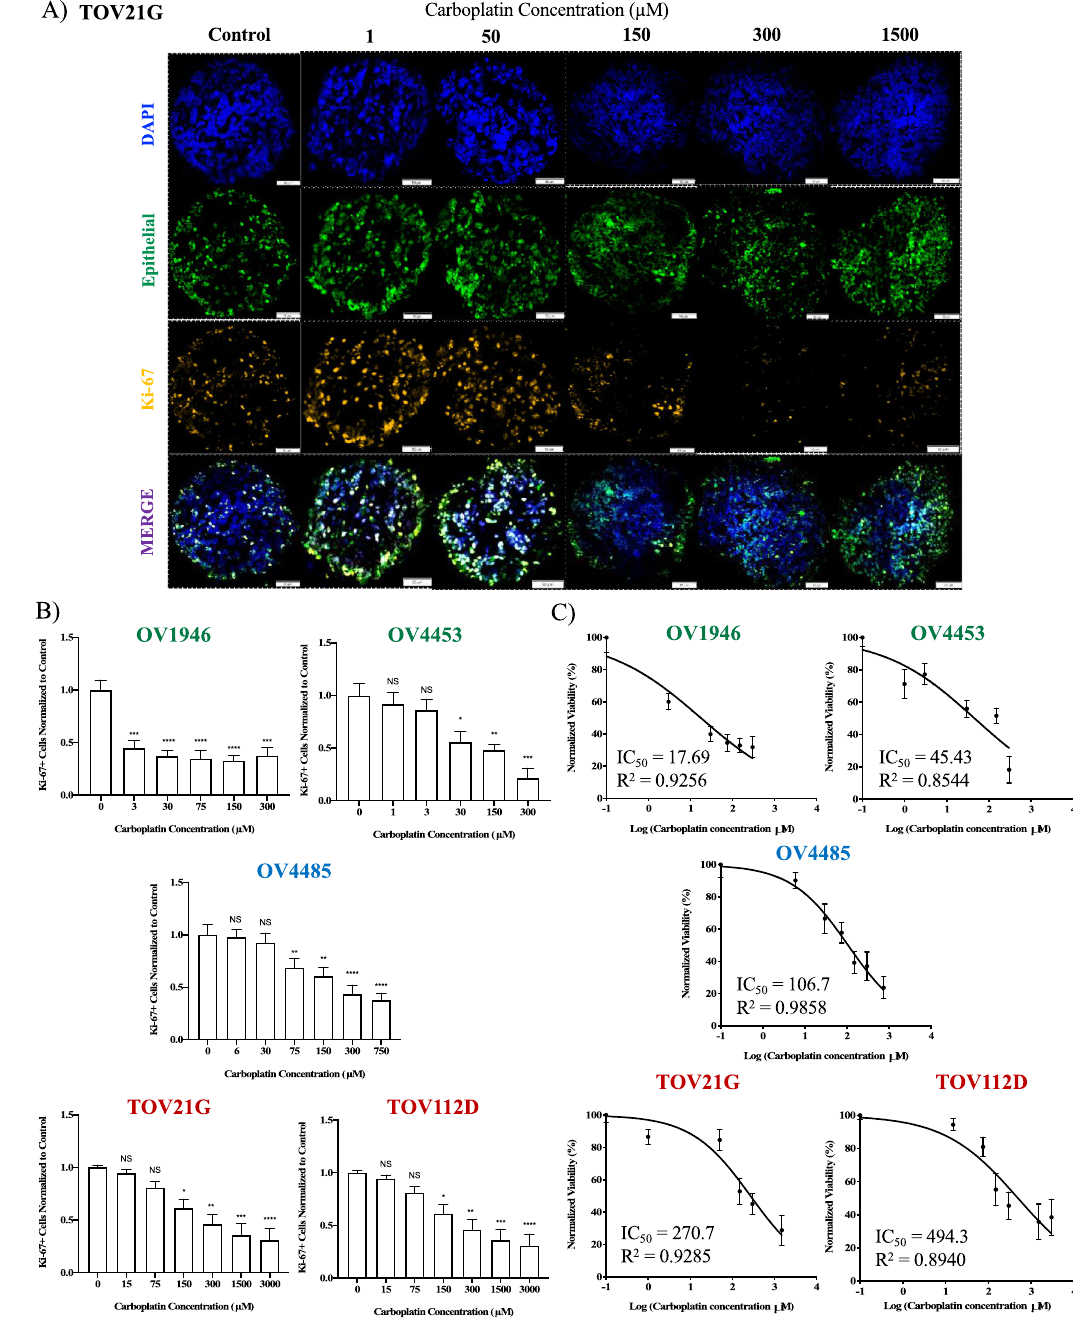
Figure 4. Response of EOC 3D ex vivo tumor model to carboplatin. MDTs derived from several cell line xenograft tumors (OV1946, OV4453, OV4485, TOV21G and TOV112D) were treated with carboplatin at various concentrations (µM) for a 16-h induction followed by a 24-h recovery treatment regimen. ( A) Representative IF staining for DAPI, mitochondria and cytokeratin 8/18 (human epithelial cancer cells) and Ki-67 of treated TOV21G MDTs. ( B) Proliferation index, bar graphs are Ki-67 staining normalized to control for each cell line. ( C) Dose-inhibition curves showing IC 50 of each cell line. Sensitive cell lines are indicated in green fonts, intermediate in blue and resistant in red. Data are the mean ± SEM. A total of 15 MDTs (technical replicates) were analyzed per condition for each cell line from one xenograft. Scale bar = 50 µm, Magnification = 20x. N.S. = non-significant. * p < 0.05, ** p < 0.01, *** p < 0.001, **** p <